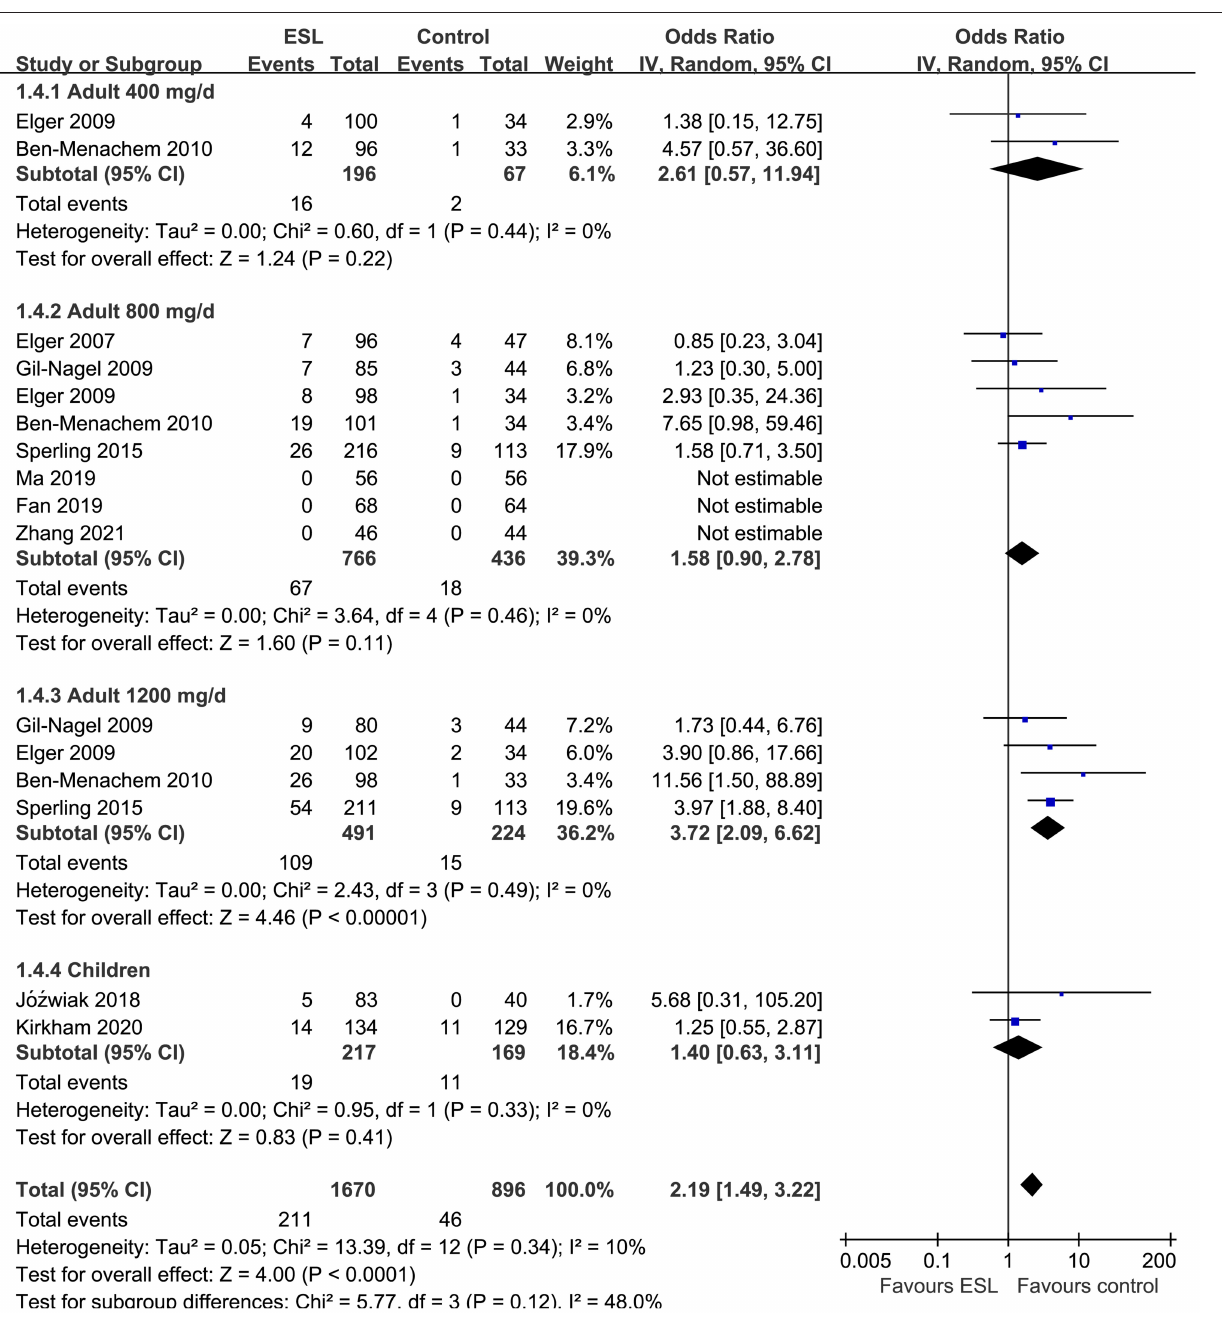
FIGURE 5 | Forest plots for the meta-analysis of the influence of adjunctive ESL on the incidence of severe AE leading to drug discontinuation in adults with FOE according to dose of ESL and in children with all